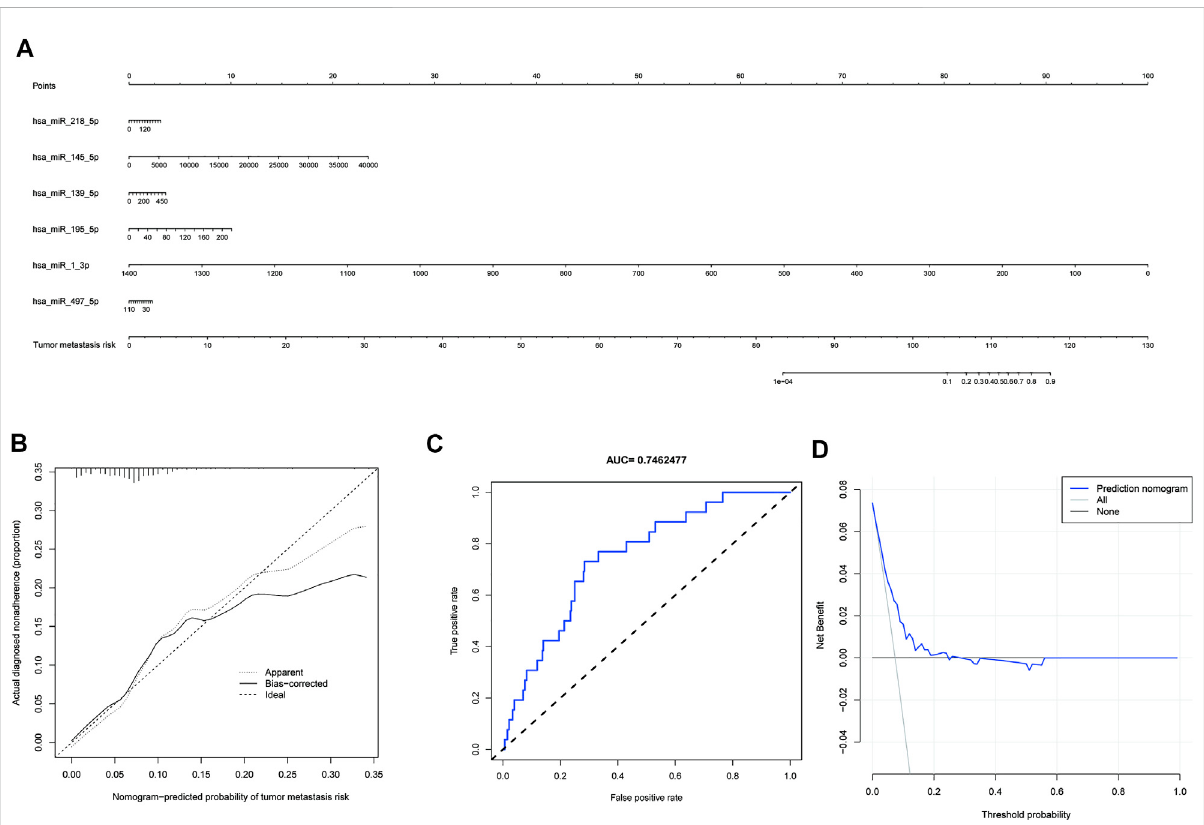
FIGURE 4 A predictive model for gastric cancer metastasis risk based on microRNAs associated with downregulated PSAT1 expression. (A) . Nomogram models based on six miRNAs (hsa-miR-1-3p, hsa-miR-139-5p, hsa-miR-145-5p, hsa-miR-195-5p, hsa-miR-218-5p, and hsa-miR-497-5p); (B) . Calibration curve for nomogram model; (C) . ROC curve of nomogram model (AUC = 0.746); (D) . Clinical decision curves illustrating the bene fi ts of using the miRNA nomogram